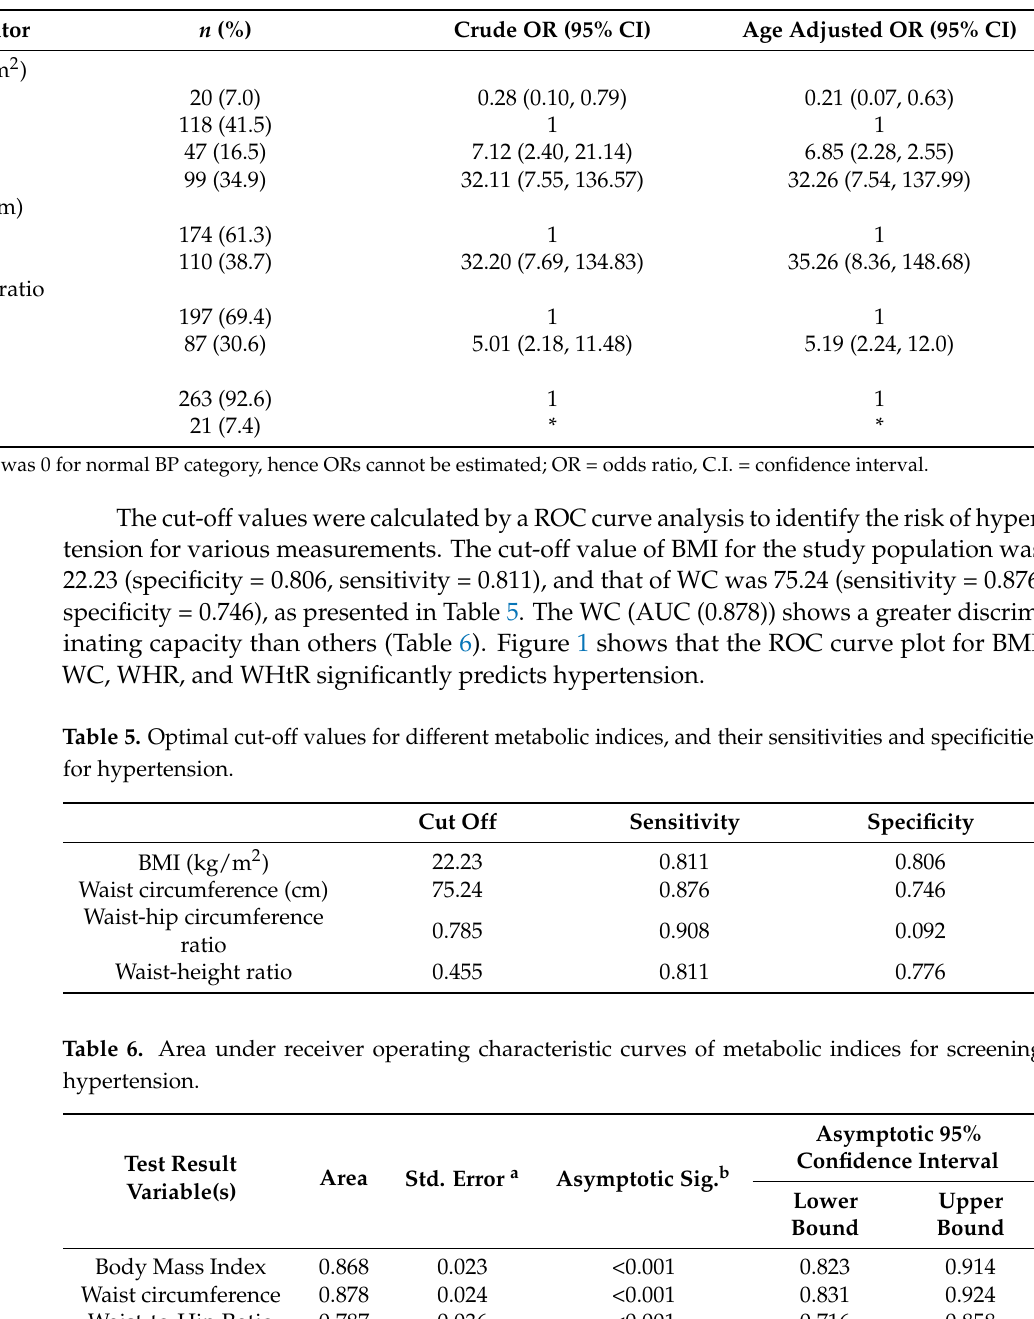
Table 4. The prevalence of overweight/obesity and odds ratio for hypertension (prehypertension, or stage 1 and stage 2) compared to normal blood pressure.